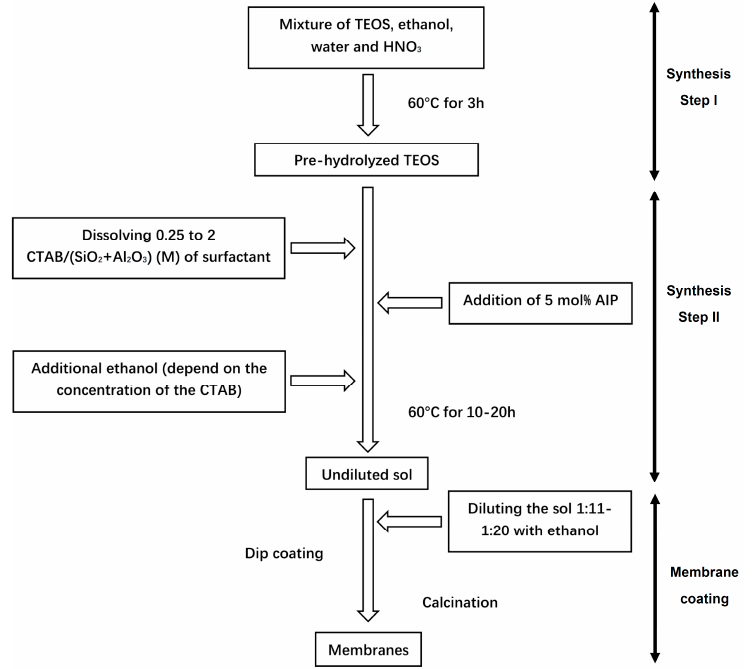
Figure 1. Synthesis process of the membranes with different cetyltrimethylammonium bromide (CTAB) concentration.